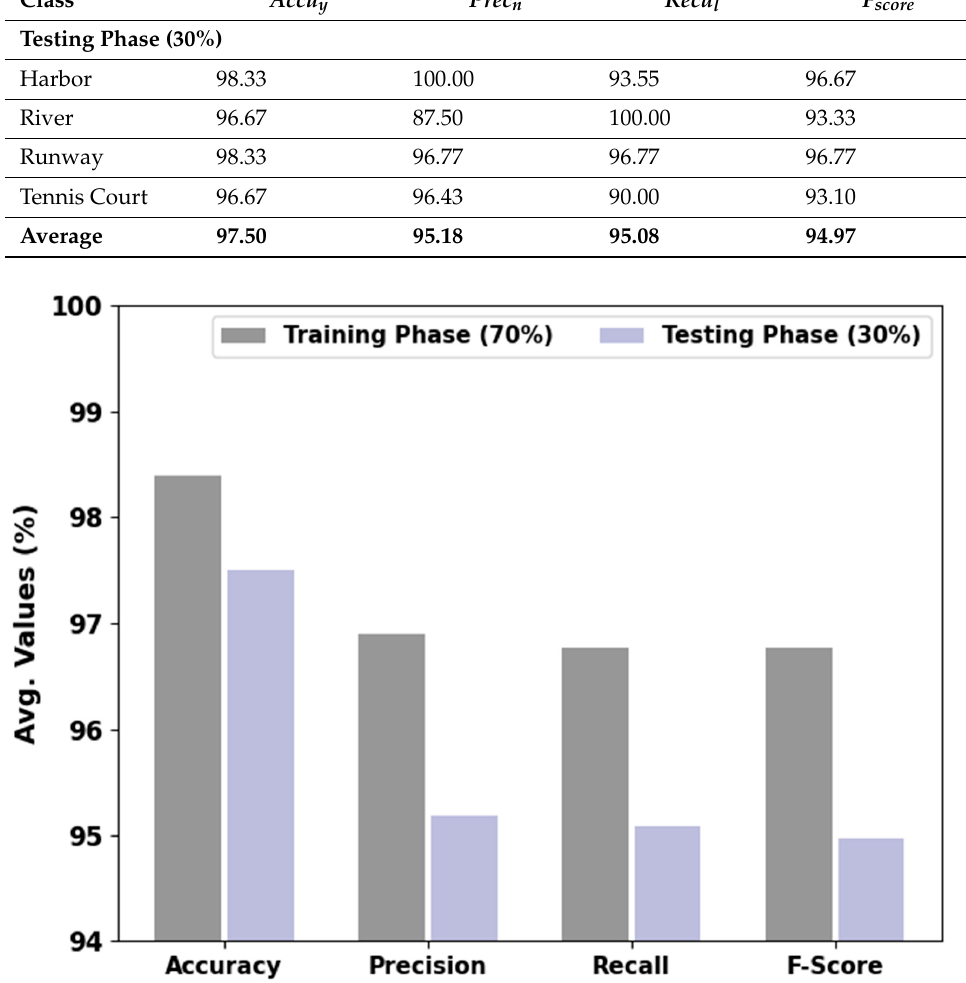
Remote Sens. 2023 , 15 , x FOR PEER REVIEW Figure 8. Average outcomes of the proposed BSBE-PPODLC approach on 70:30 on TR/TS datasets. The TACC and VACC performance outcomes of the BSBE-PPODLC methodology, are shown in Figure 9. The figure implies that the BSBE-PPODLC technique achieved im- proved performance with increased TACC and VACC values. Notably, the BSBE- PPODLC method reached the maximum TACC outcomes.